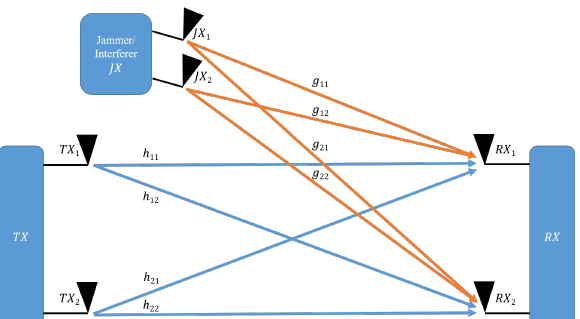
Figure 2. Illustration of 2 × 2 Alamouti space time coding (STC) in the presence of